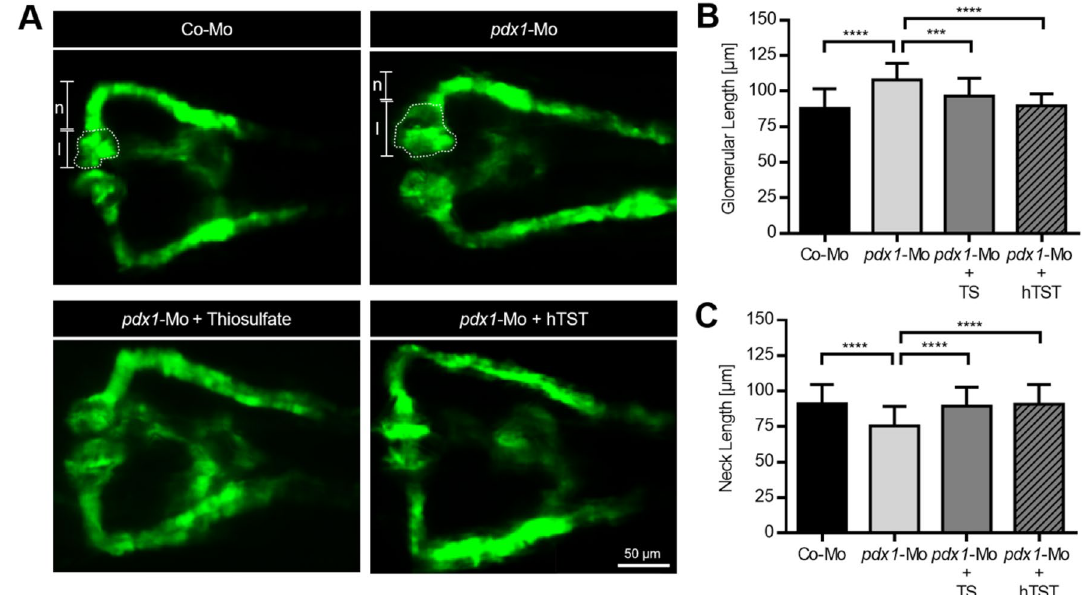
Figure 2. Thiosulfate and human thiosulfate sulfurtransferase treatment rescues pdx1 morpholino- induced hyperglycemic pronephros damage. ( A ) Representative visualization of the zebrafish pronephros in Tg(wt1b:EGFP) embryos at 48 hpf with different experimental conditions. Embryos injected with only a control morpholino (Co-Mo) show the typical pronephros morphology at 48 hpf, while injection with the pdx1 morpholino (pdx1-Mo) leads to a hyperglycemia-mediated pronephros phenotype with an increased glomerular length and a shortened pronephric neck length. Treatment via either exposure to 10 mM thiosulfate (TS) or injection of 1 nl human thiosulfate sulfurtransferase (hTST) at a concentration of 1 µg/µL rescued the pronephros phenotype in the pdx1 morphants. ( B – C ) Evaluation of the pronephros phenotype in Tg(wt1b:EGFP) embryos at 48 hpf shows significant rescue of both ( B ) glomerular length and ( C ) pronephric neck length by TS and hTST treatment in pdx1 morphants (n = 45 for Co-Mo and pdx1-Mo, n = 30 for the TS and hTST groups). Measurements for glomerular length (l) and pronephric neck length (n) have been marked and the glomerulus was encircled for one pronephric side in two images in ( A ) as example. Lengths given in ( B – C ) represent the total sum of both the left and right side measurements added up. The scale bar is 50 μm in (A). Statistics utilized one-way ANOVA + Sidak’s post-hoc ( B – C ); mean + SD reported; *** p < 0.001, **** p <